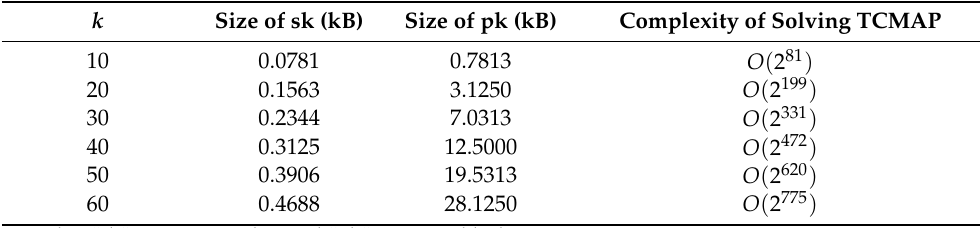
Table 2. Performance comparison under some different parameters.